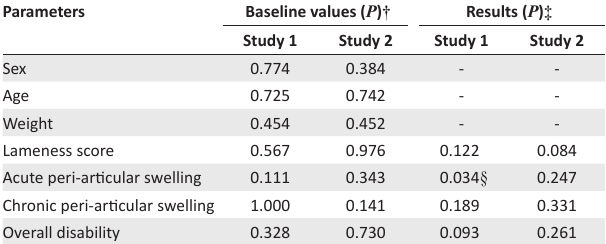
TABLE 4: Statistical analysis of the baseline values as well as study results.